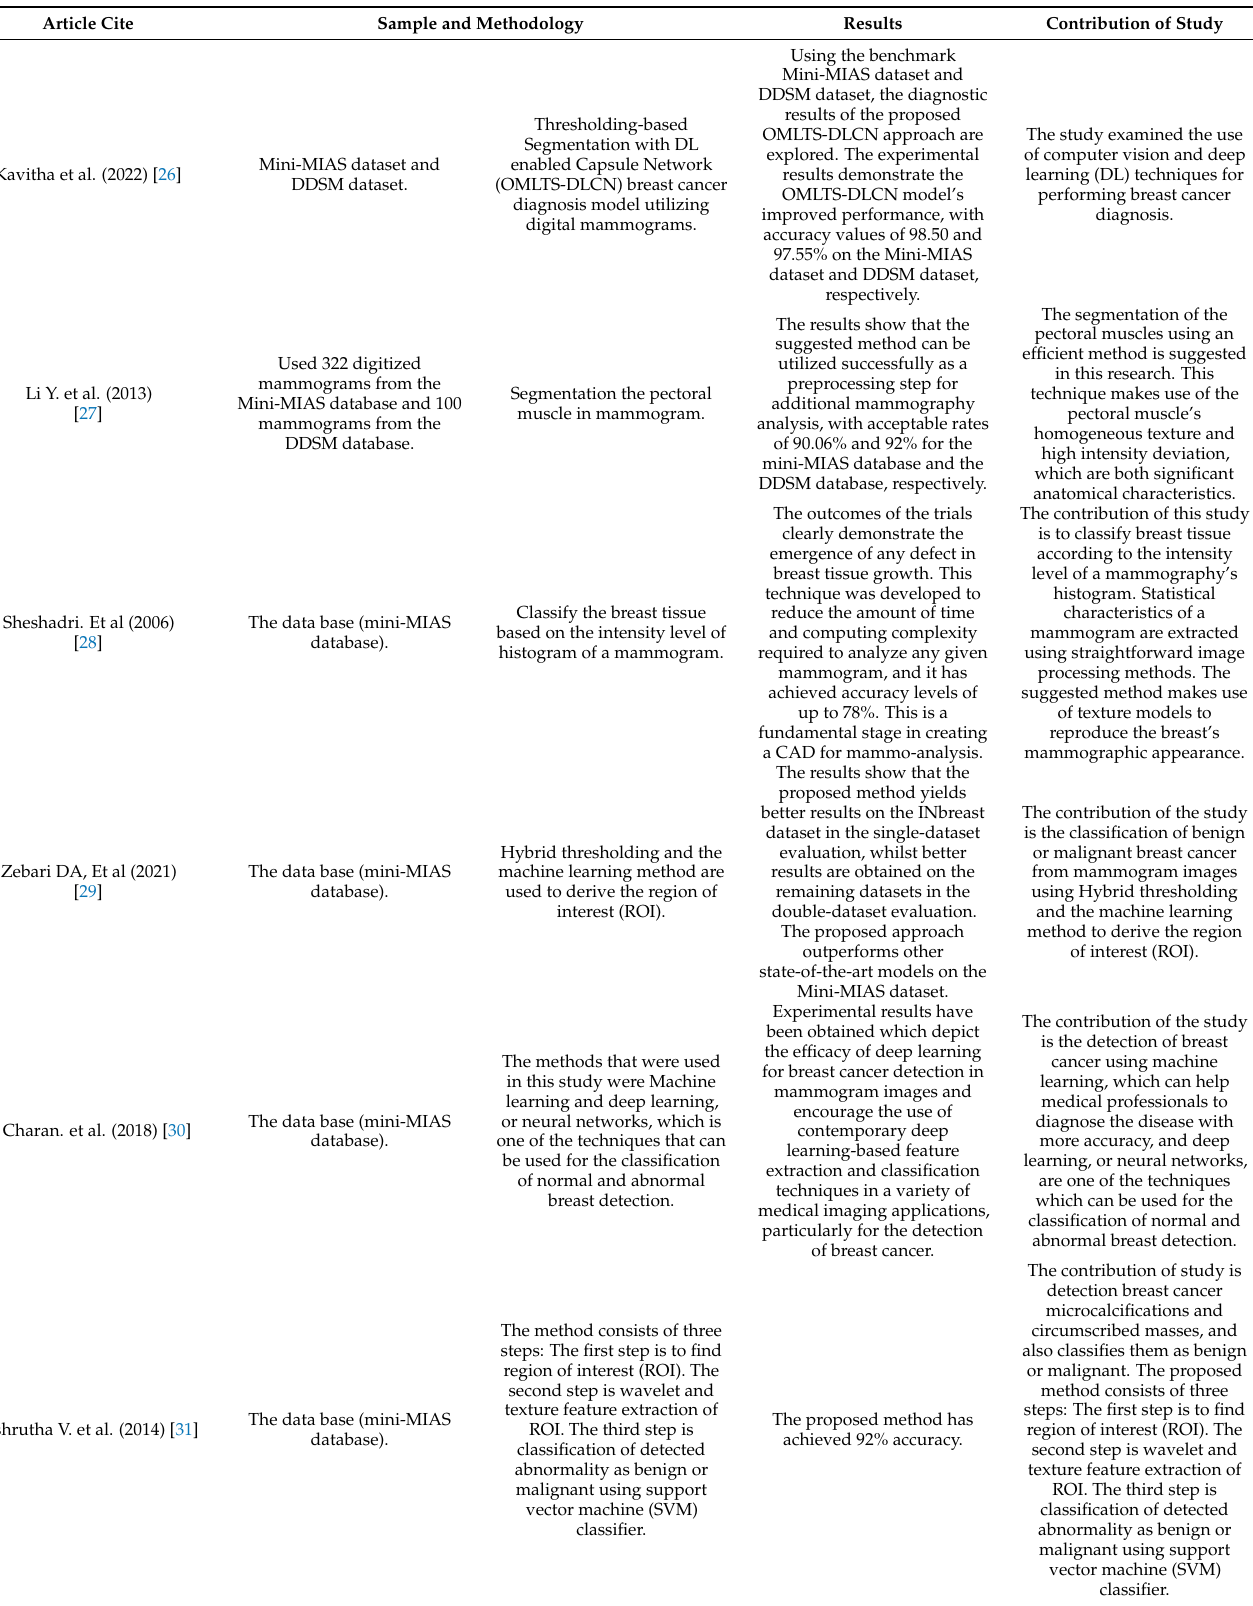
Table 2. Comparison between the results achieved and the results of previous related studies based on the same